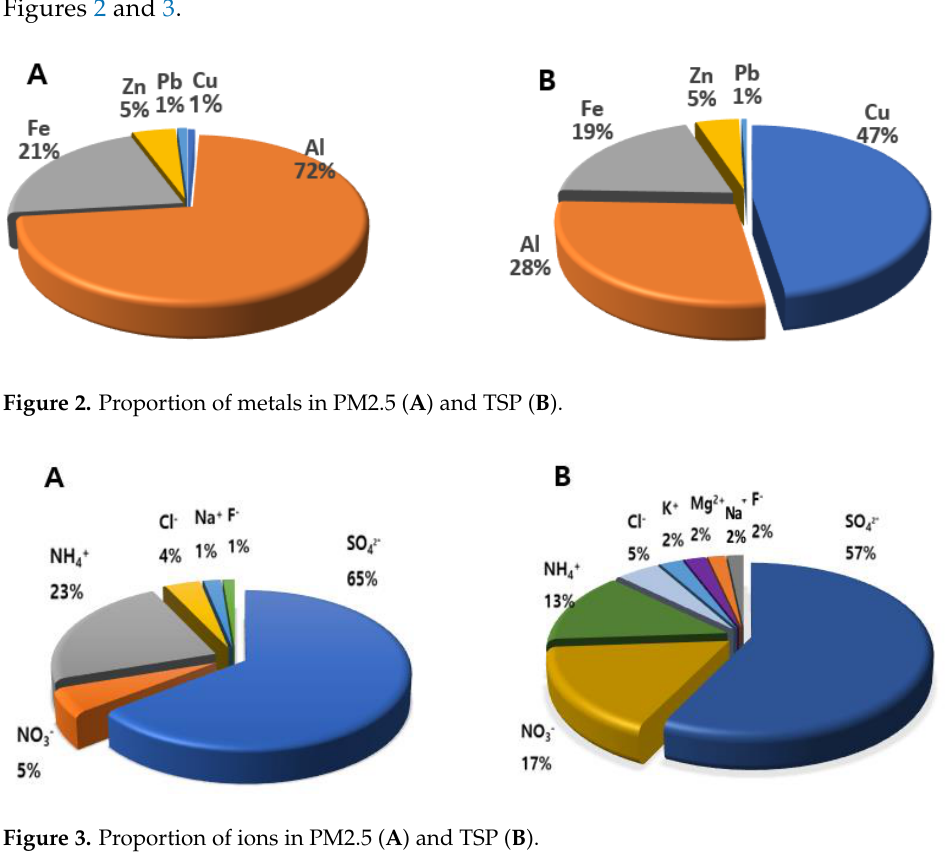
Figure 3. Proportion of ions in PM2.5 ( A ) and TSP ( B ).